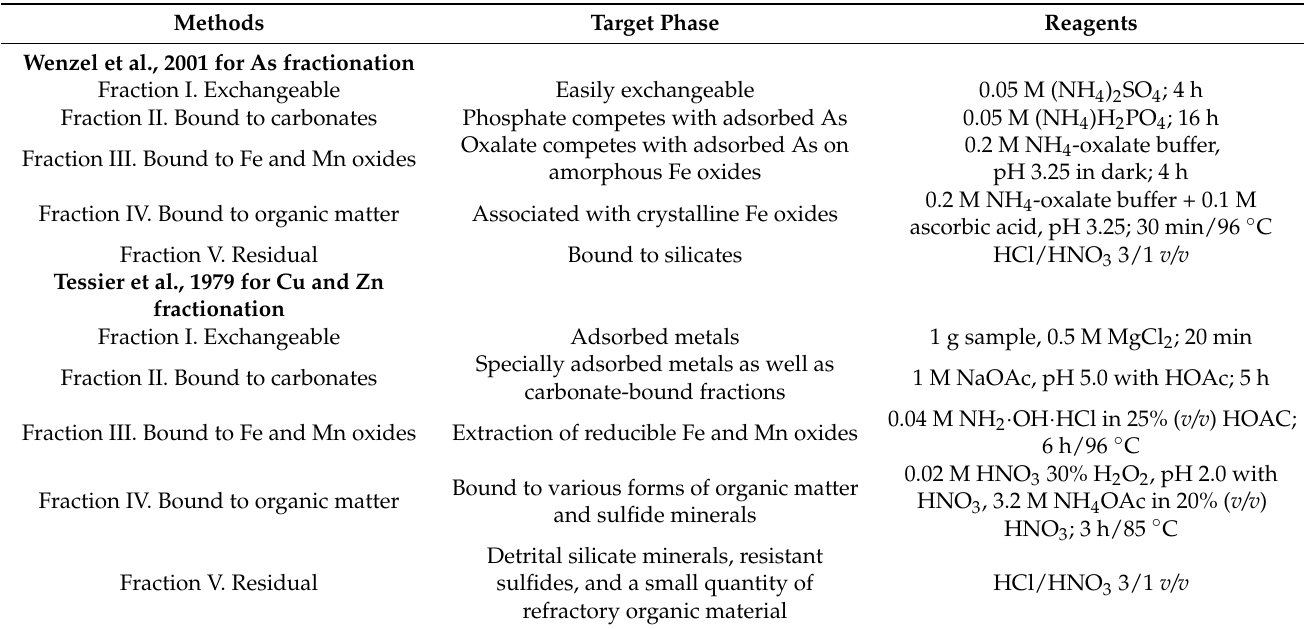
Table 1. The procedure of sequential extraction